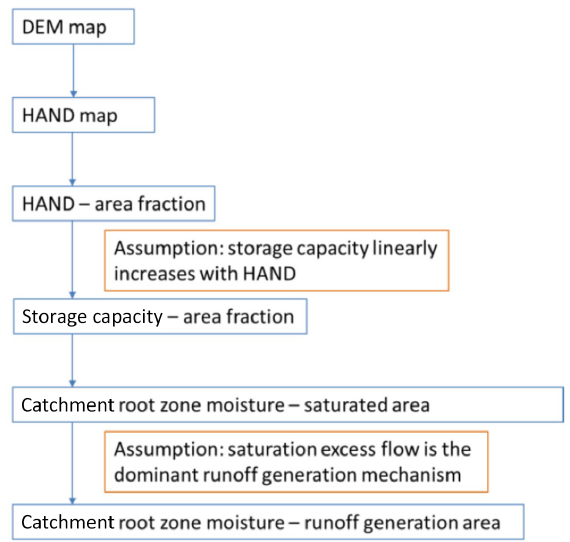
Figure 5. Model structure and free parameters, involving four runoff generation models (HBV-type, TOPMODEL, HSC, and HSC-MCT). HBV-type has S uMax and beta two free parameters; TOPMODEL and HSC models have S uMax as one free parameter; and the HSC-MCT model does not have a free parameter. In order to simplify calibration process and make fair comparison, the inter- ception storage capacity ( S iMax ) was fixed as